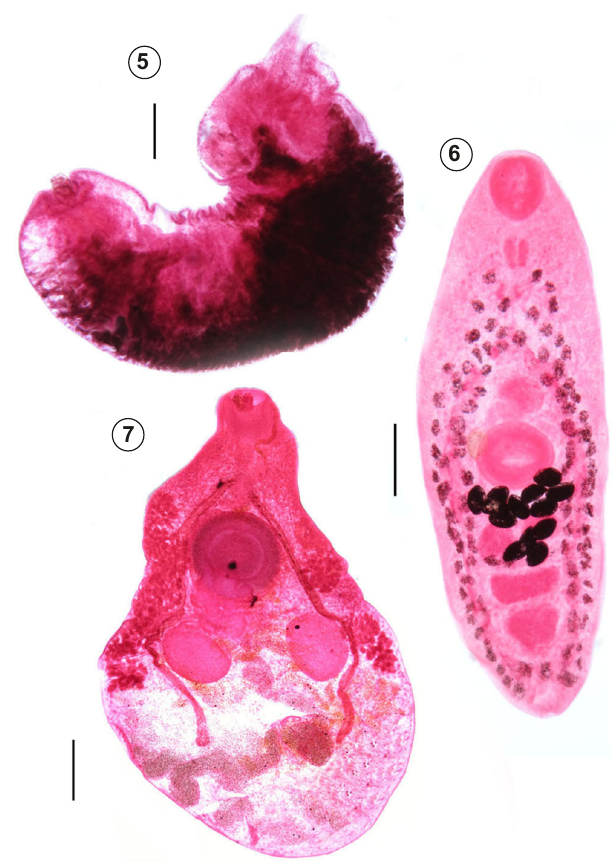
Austrodiplostomum mordax Szidat and Nani, 1951 collected